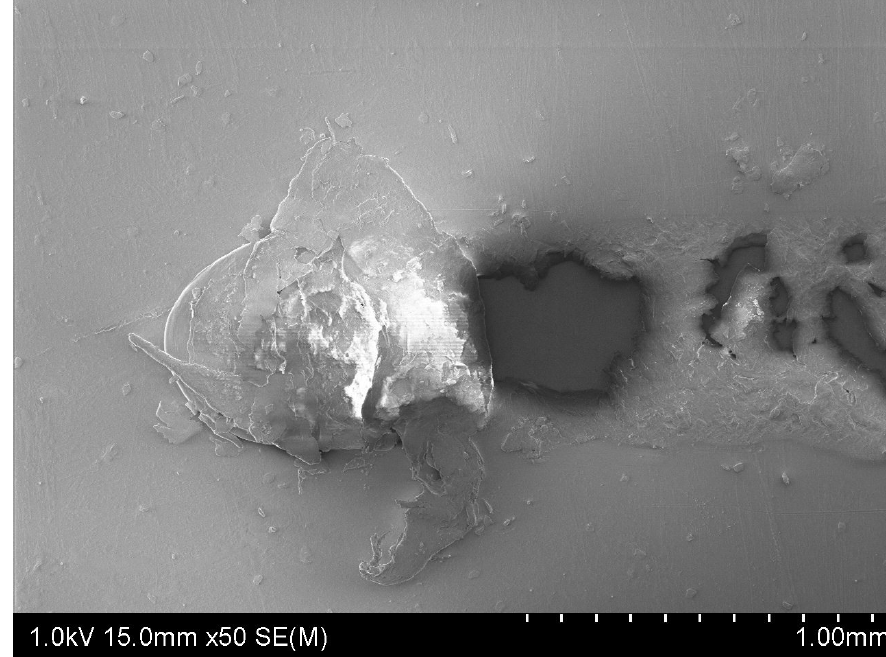
Figure 14. SEM image of a damaged zone on the top layer.